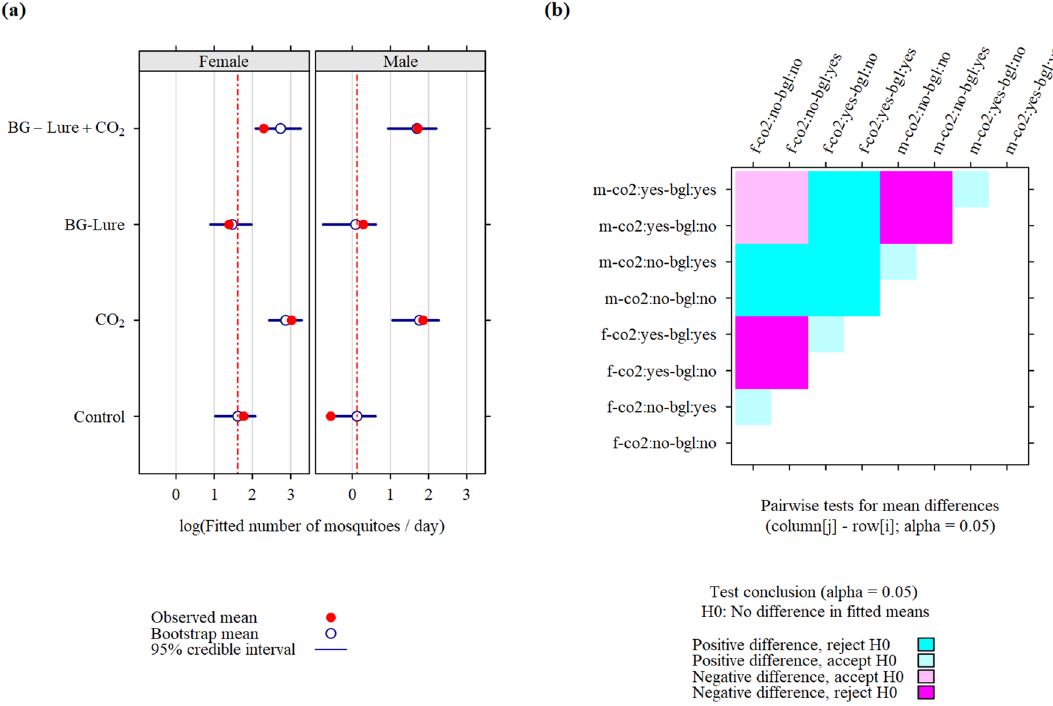
Figure 5. Fitted apparent density ( a ) and corresponding pairwise tests ( b ) for differences in fitted means for adult Culex quinquefasciatus mosquitoes collected in 2020 (89 trapping sessions) during a field experiment in La Reunion. Coding scheme for row and column labels: sex (m/f)—CO2 (co2:yes/co2:no)—BG-Lure (bgl:yes/